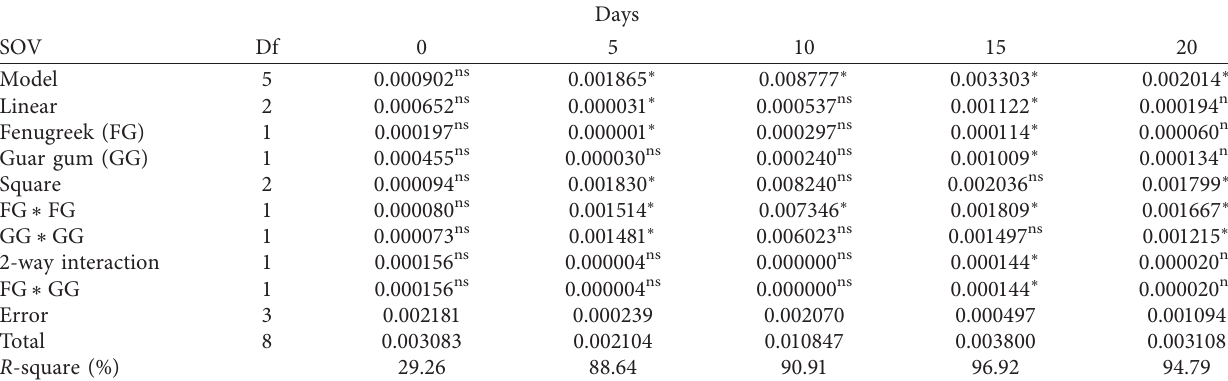
Table 4: Analysis of variance (sum of the square) for response surface model of fruit firmness during storage.